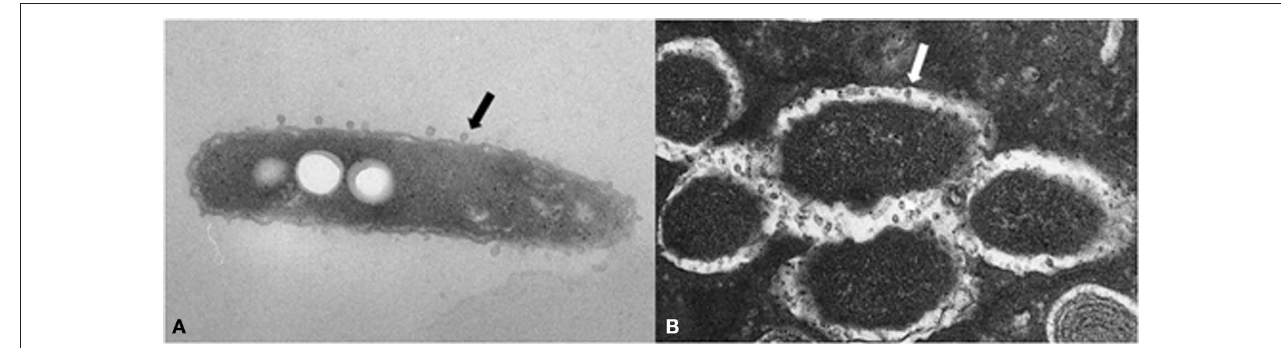
Figure 3 | electron micrographs of L. pneumophila and outer membrane vesicles. L. pneumophila sheds OMVs (arrows) from its surface during growth in liquid media (A) and within phagosomes of Dictyostelium discoideum